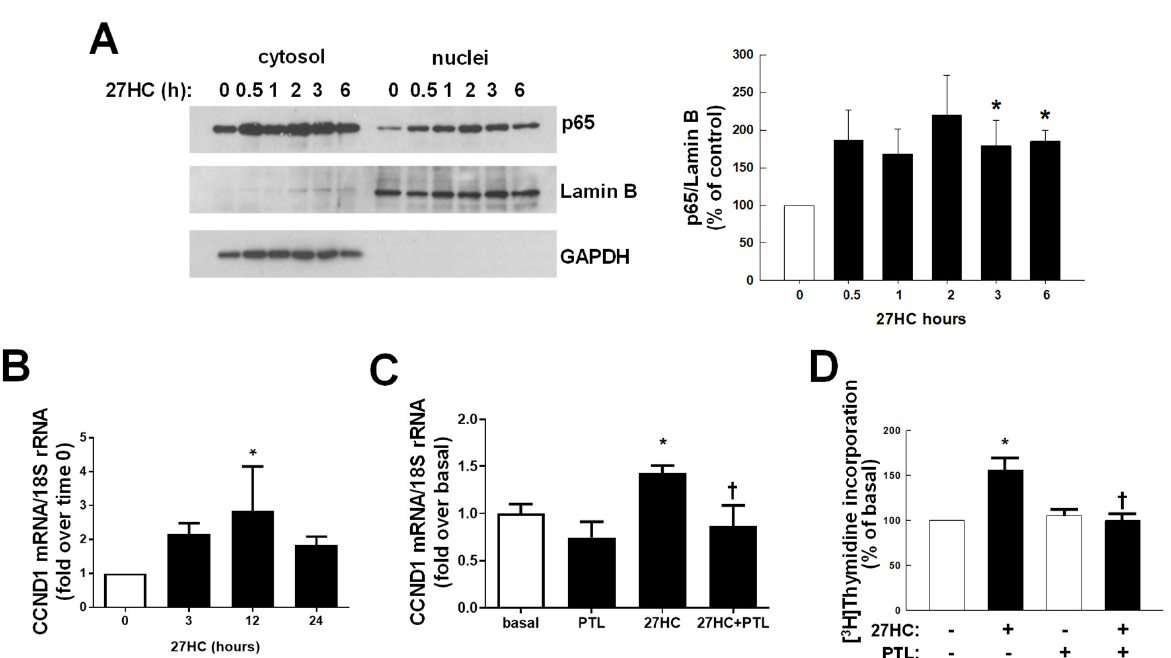
Figure 3. NF κ B is part of 27HC-activated pathway and is required for cyclin D1 transcription. ( A ) . MDA-MB-231 cells were treated with 27HC (10 − 6 M) for 0–6 h, cytosolic and nuclear fractions were obtained, and Western blotting was performed for p65, Lamin B and GAPDH. Left panels display representative Western blots, and right panels provide summary data. Values are mean ± SEM, n = 5, * p < 0.05 vs. control (0 h). ( B , C ) QPCR analysis of cyclin D1 in MDA-MB-231 cells treated for increasing times with 27HC (10 − 6 M) alone ( B ) or combined with parthenolide (PTL) (5 × 10 − 6 M) ( C ). ( D ) Cells were treated for 48h with 27HC (10 − 6 M) and PTL (5 × 10 − 6 M) alone and combined, proliferation was evaluated by 3 H-thymidine incorporation over 6 h. * p < 0.05 vs. basal (untreated cells); † p < 0.05 vs. 27HC treated cells.